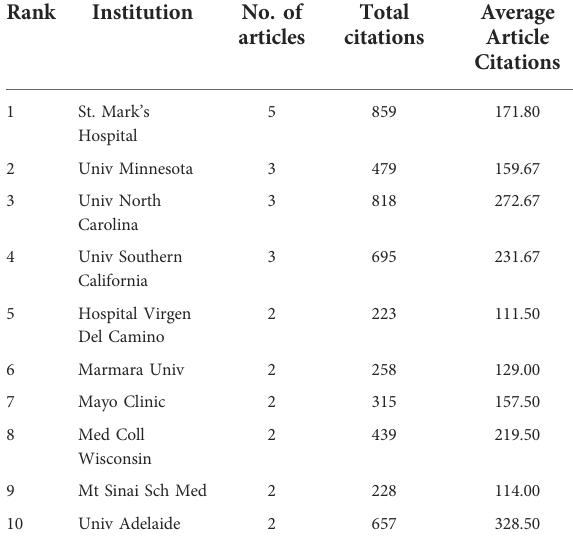
TABLE 2 The top 15 in fl uential countries. TABLE 3 The top 10 most-in fl uential